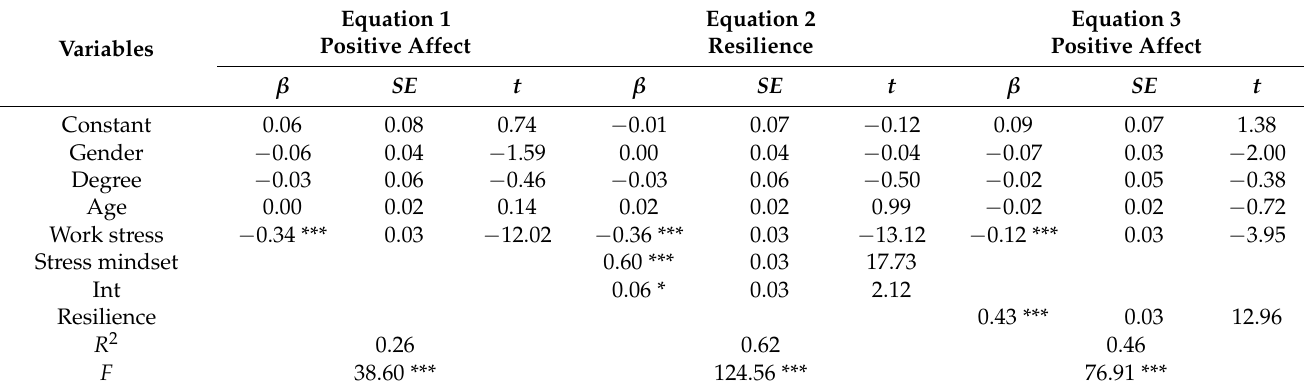
Table 3. Moderated mediating effect of work stress on positive affect ( N = 456).